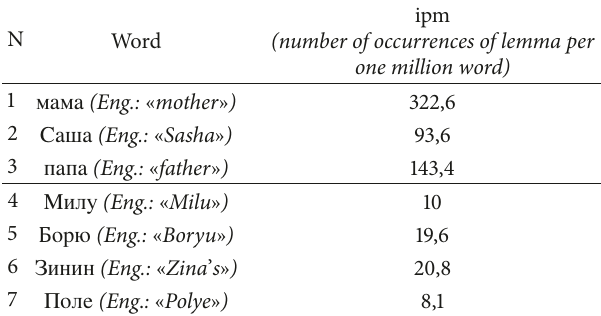
Table 6: Frequency of occurrence in the Russian language of the tested words with the highest and the lowest scores of recognition (according to the results of the current